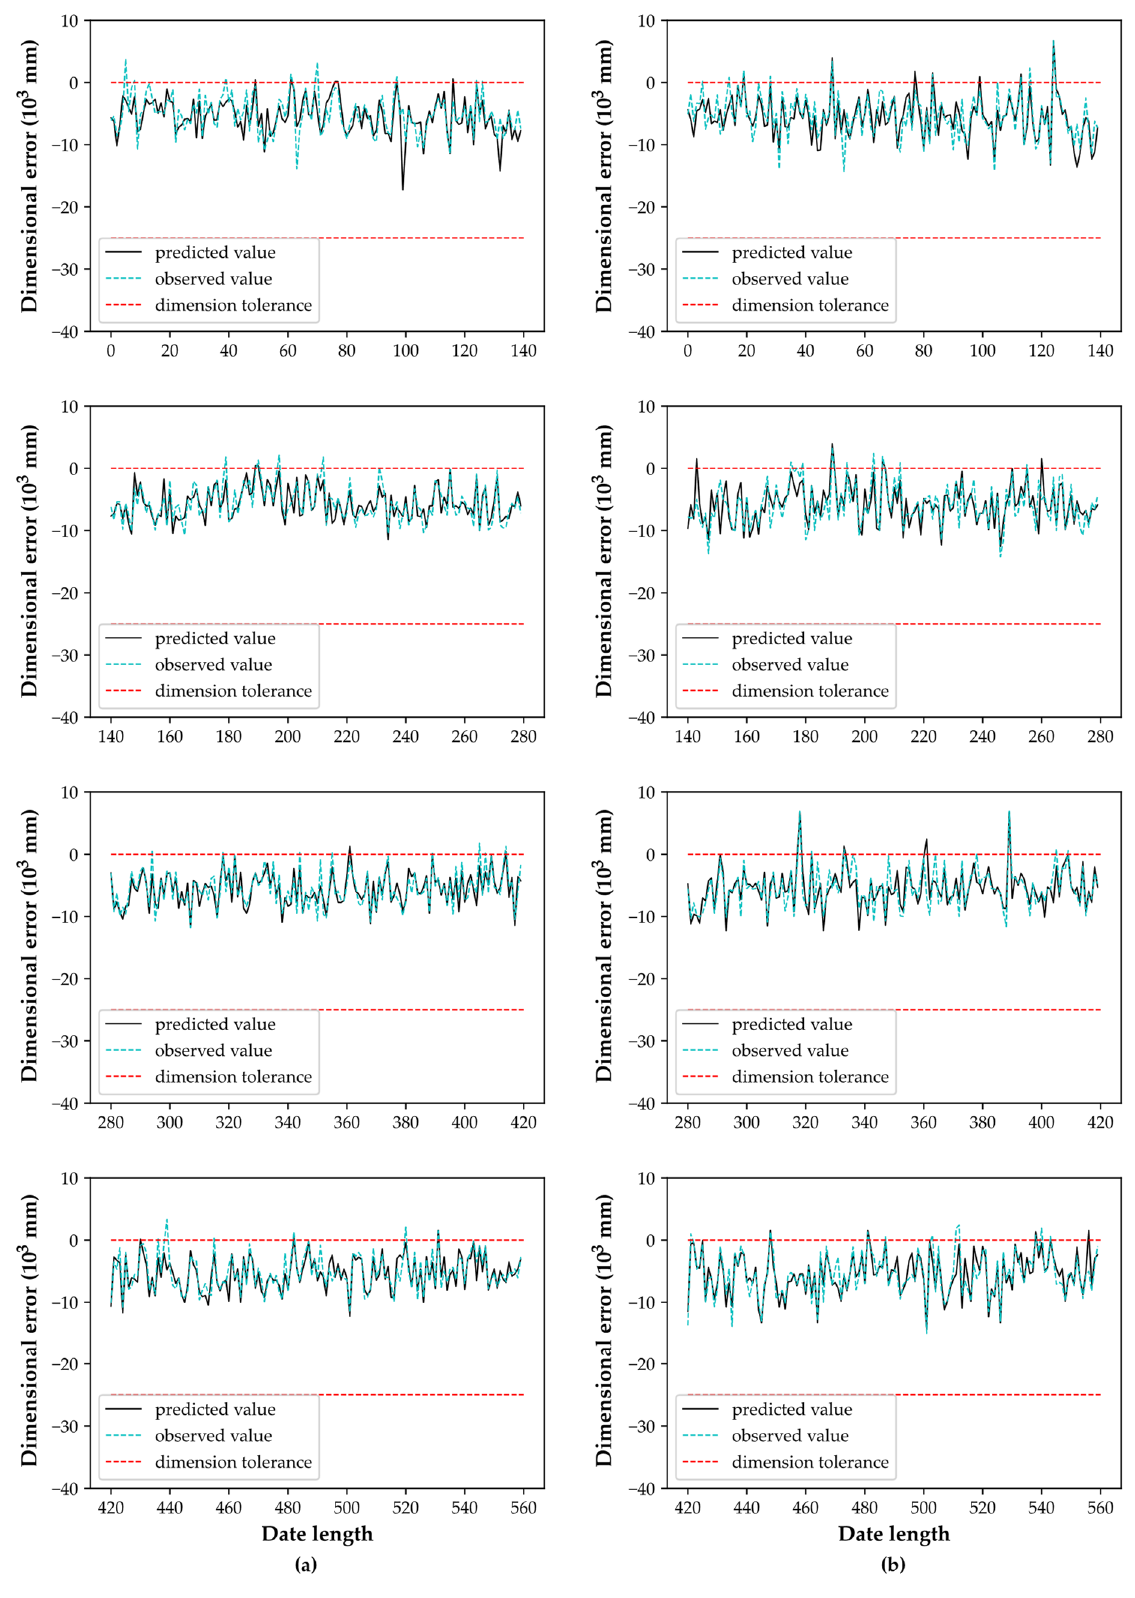
Figure 13. The prediction results of dimensional error. ( a ) The prediction of diameter I, ( b ) The prediction of diameter II.